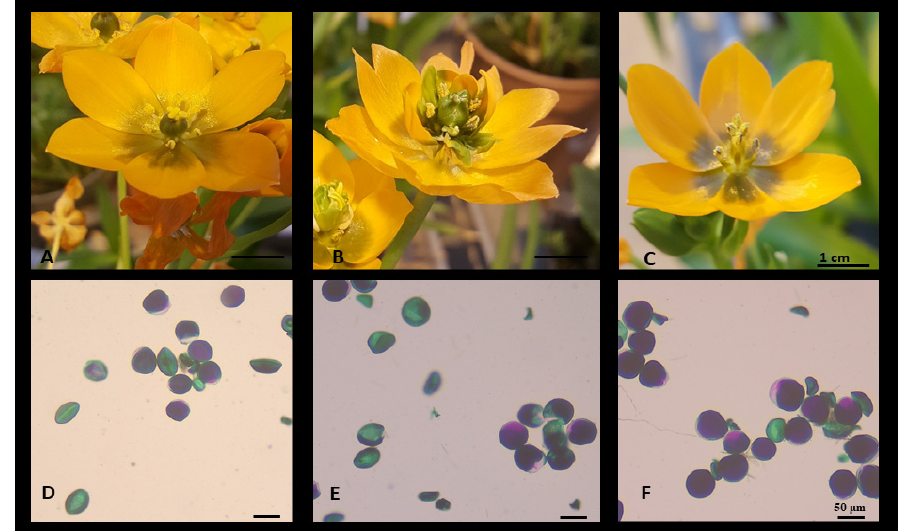
Figure 4. Pollen morphology of 2 selected variants compared to a control line: Panels ( A ) and ( D ) show a normal flower and its pollen phenotype, panels ( B ) and ( E ) show a variant flore pleno with altered tepals number and relative pollen, and panels ( C ) and ( F ) show an acarpous flower type and related pollen. The purple colour indicates viable pollen grains, whereas green is an indication of nonviable pollen